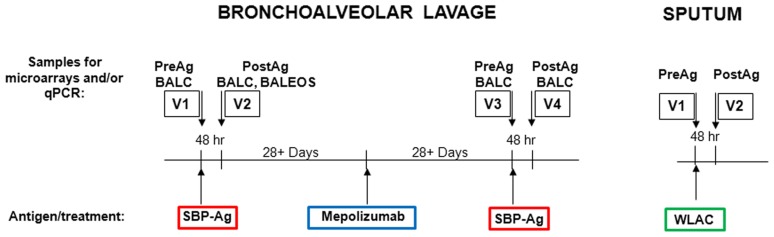
Bronchoalveolar lavage and sputum timelines.Atopic mild asthmatics underwent bronchoalveolar lavage (BAL) followed by segmental challenge with an allergen (SBP-Ag) on visit 1 (BAL V1). 48 h later on visit 2 (BAL V2), BAL was performed at the site of the challenged segment. One month later, a single dose of mepolizumab was administered. One month after dosing, BALs were repeated both before and after SBP-Ag. BAL cells (BALC) were prepared on visits 1, 2, 3, and 4 and airway EOS (BALEOS) were purified on visit 2. For the induced sputum study, sputum collection was performed followed by a whole lung allergen challenge (WLAC) on visit 1 (sputum V1). Collection of a second induced sputum was done 48 h after WLAC on visit 2 (sputum V2).